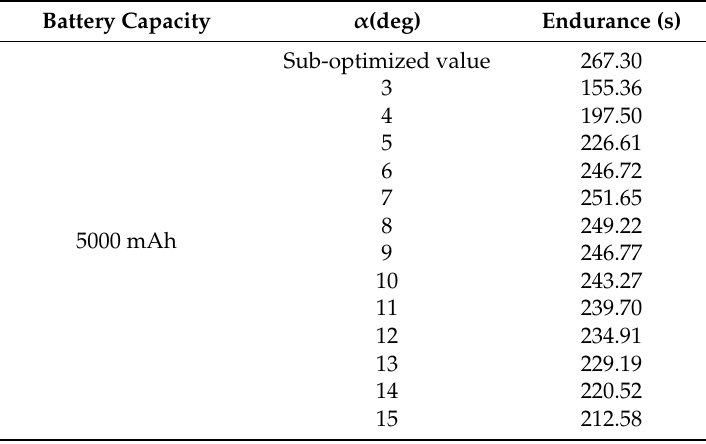
Table 2. The endurance performance versus propeller pitch